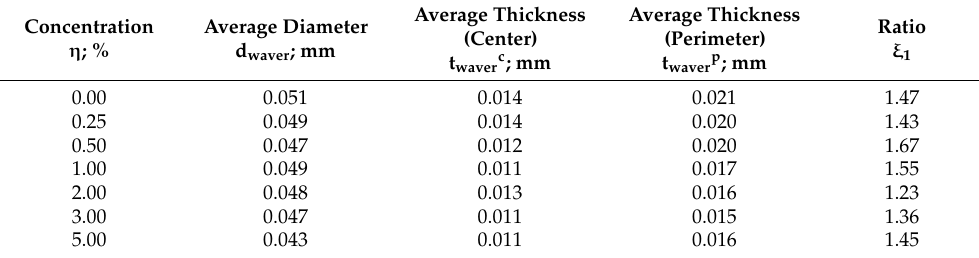
Table 7. Characteristics of the walls’